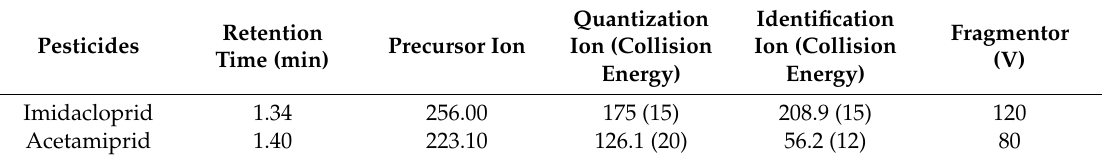
Table 3. Liquid chromatography-tandem mass spectrometry parameters of two pesticides.